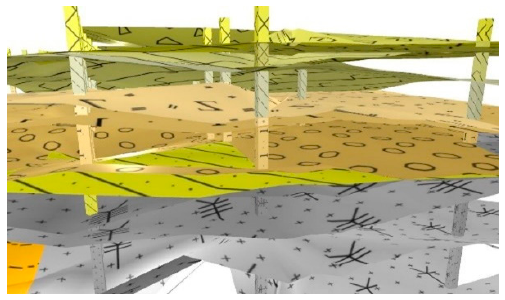
Figure 40. Borehole and stratum distributions.